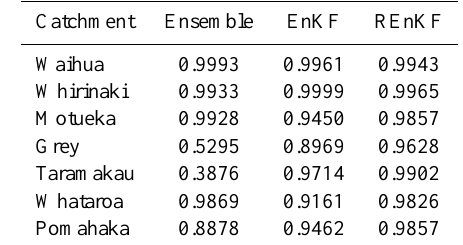
Table 4. Percentage of time flow measurement lies within ensemble bounds, calculated for time period 1 April 2011–31 March